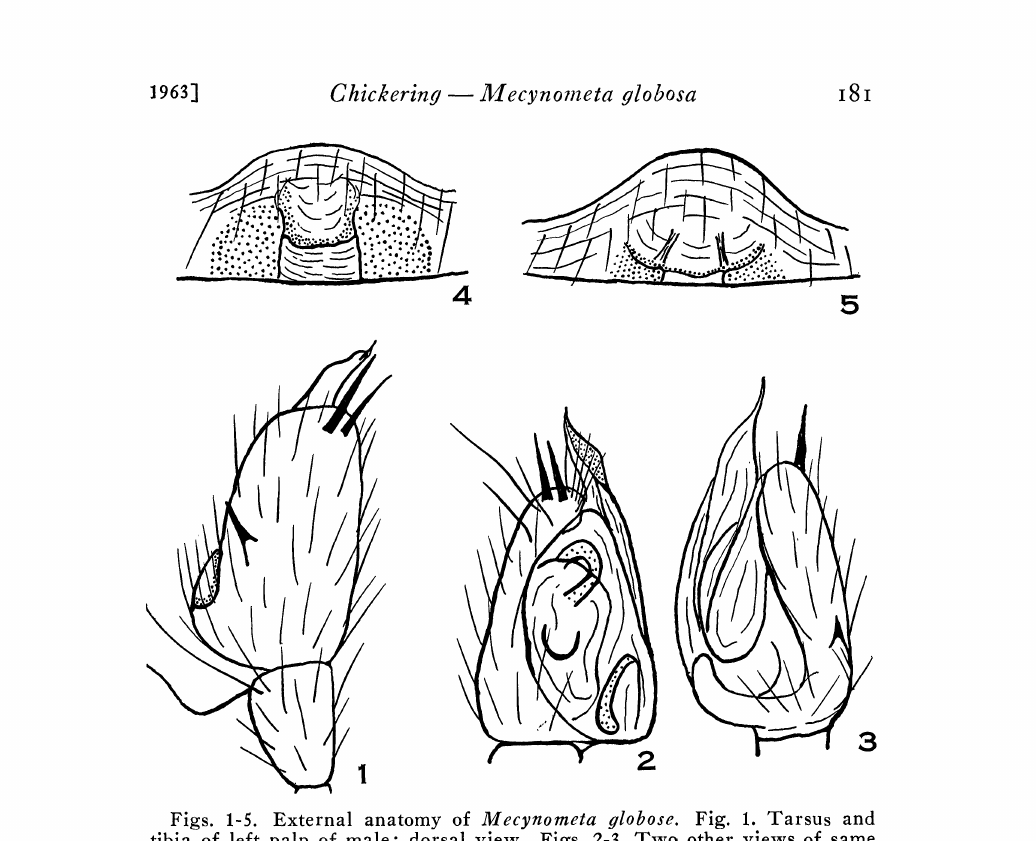
Figs. 1-5. External anatomy of Mecynometa globose. Fig. 1. Tarsus and tibia of left palp of male; dorsal view. Figs. 2-3. Two other views of same male palp. Figs. 4-5. Epigyna from two different specimens; as viewed from